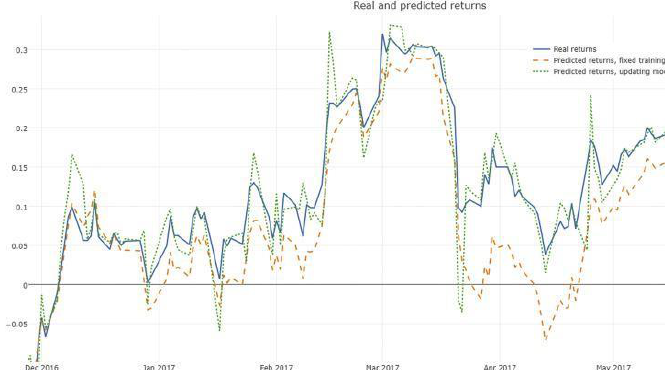
Figure 5 : Real returns and those predicted by the SVR model for the American stock BAC daily prices.